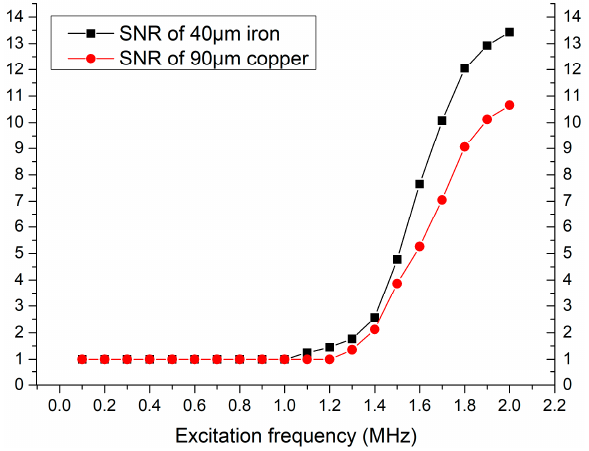
Figure 9. Frequency experiment results.